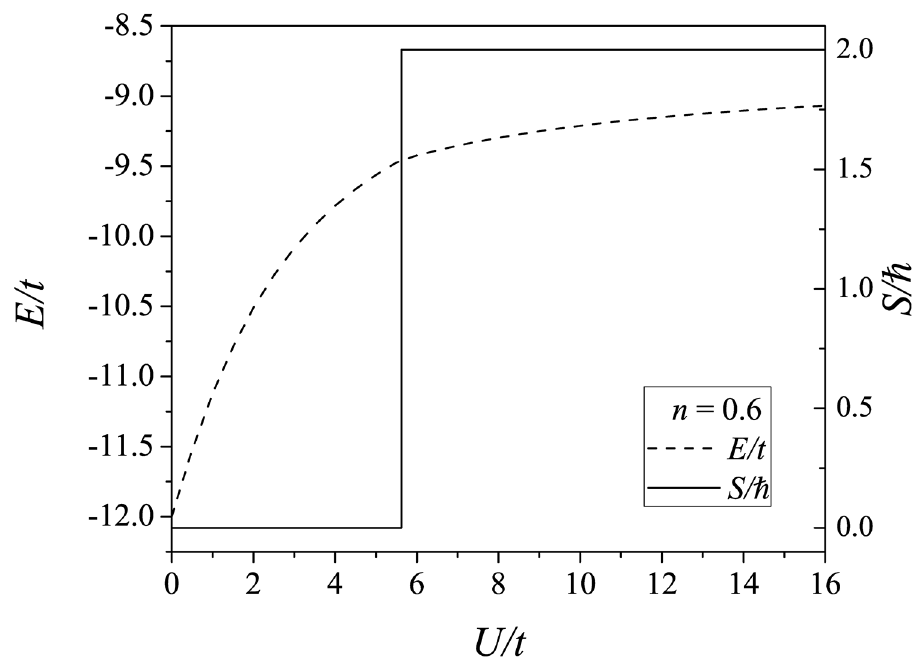
Fig 1. Ground state energy (dashed line) and total spin (solid line) of a fcc cluster as a function of U / t for a system with N s = 10 and n = 0.6.